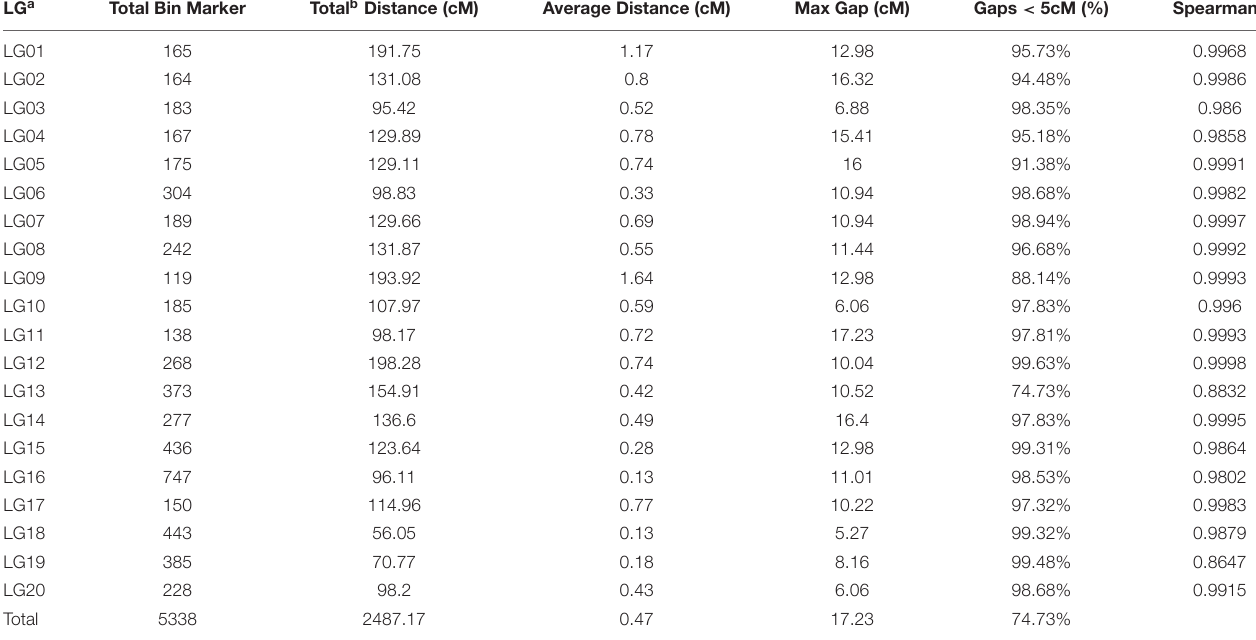
TABLE 4 | The basic information of the high-density genetic map. LG a Total Bin Marker Total b Distance (cM) Average Distance (cM) Max Gap (cM) Gaps < 5cM